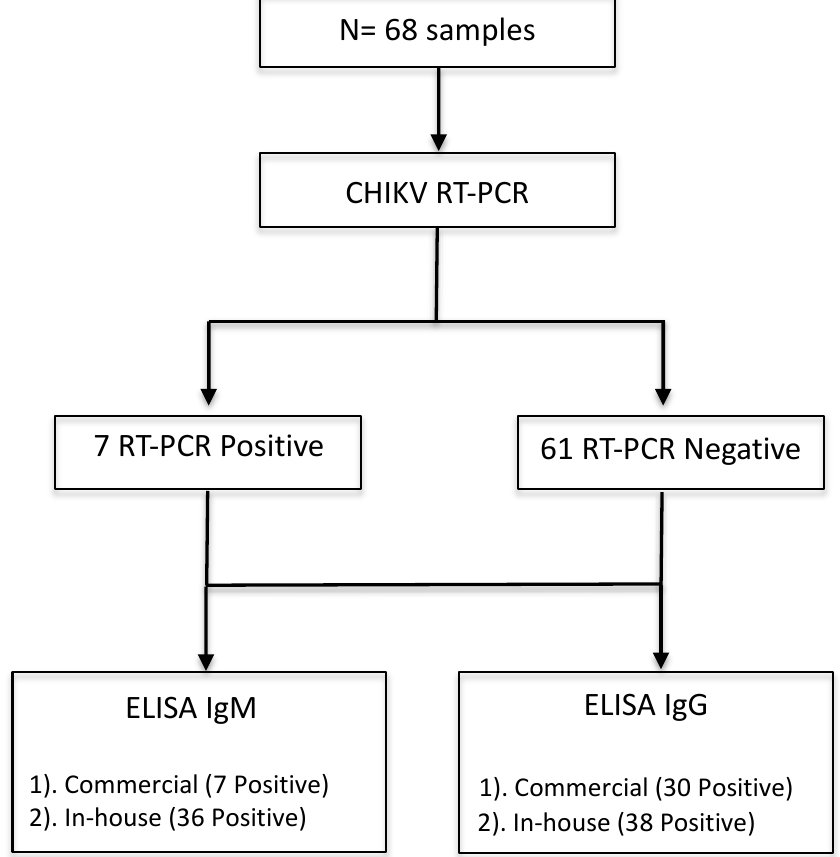
Figure2. Figure 2. Flow chart describing tests performed in samples using RT-PCR and two ELISA methodologies.